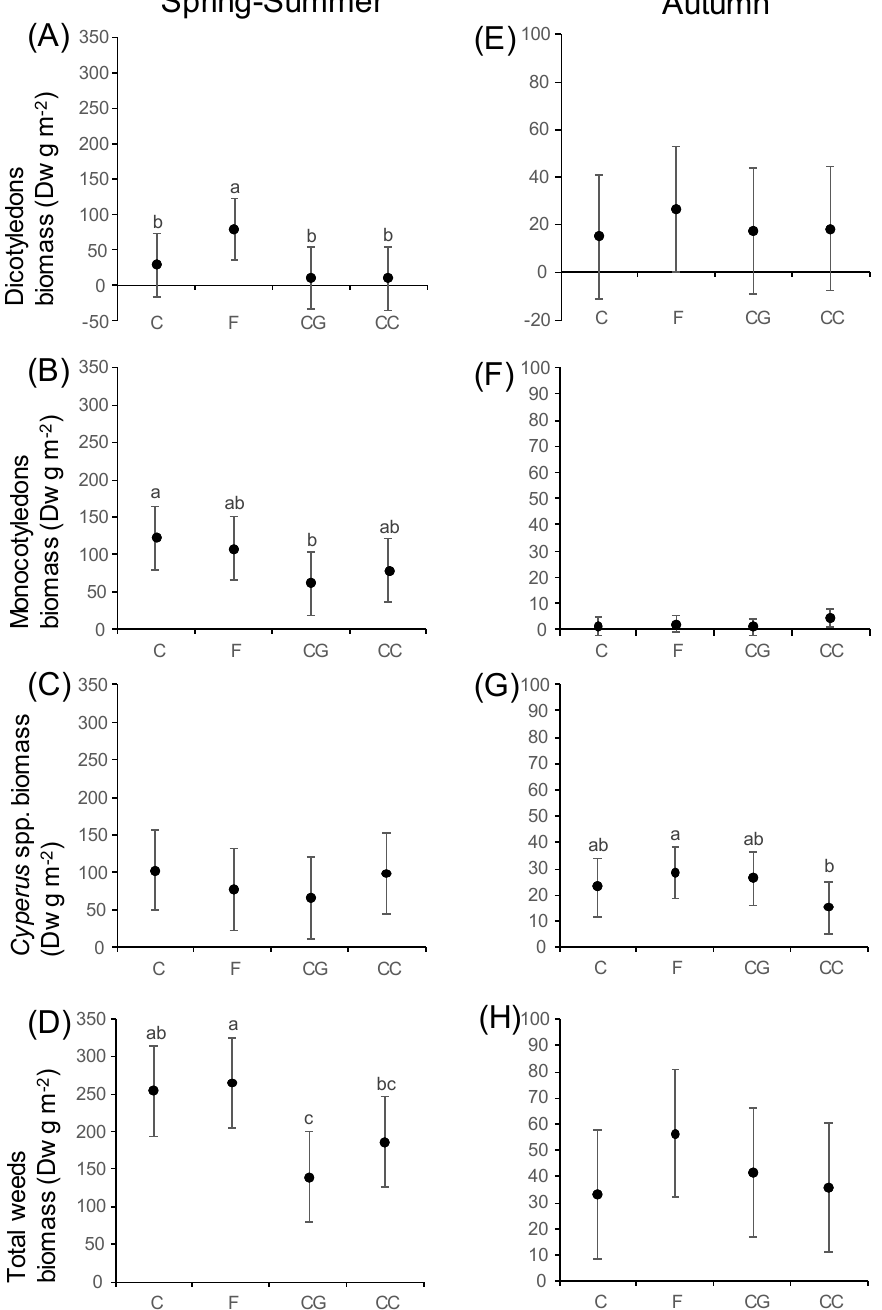
Figure 3. Effect of waste treatments on biomass of dicotyledon weeds ( A , E ); monocotyledon weeds ( B , F ); the weed Cyperus spp. ( C , G ); and total weeds ( D , H ) in experimental field plots in Spring–Summer (Experiment 3, 2020) and Autumn (Experiment 4, 2020). C = control, F = Vicia faba pod waste, CG = spent coffee grounds waste, CC = corn cob waste. Dw = dry weight. Figures show least-square mean values ( ± confidence intervals). n = 16. Least-square mean values without statistical letters are not significantly different. Different letters indicate statistical significance according to significant p values from Table S2 and lsmeans function at p ≤ 0.05.